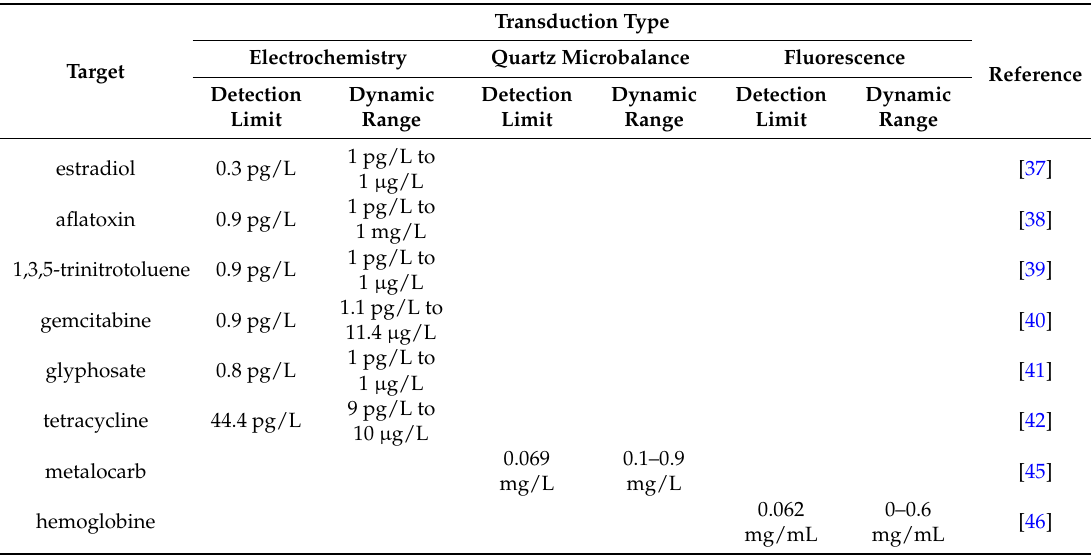
Table 1. Analytical performances of MIP-MOF-based chemical sensors.